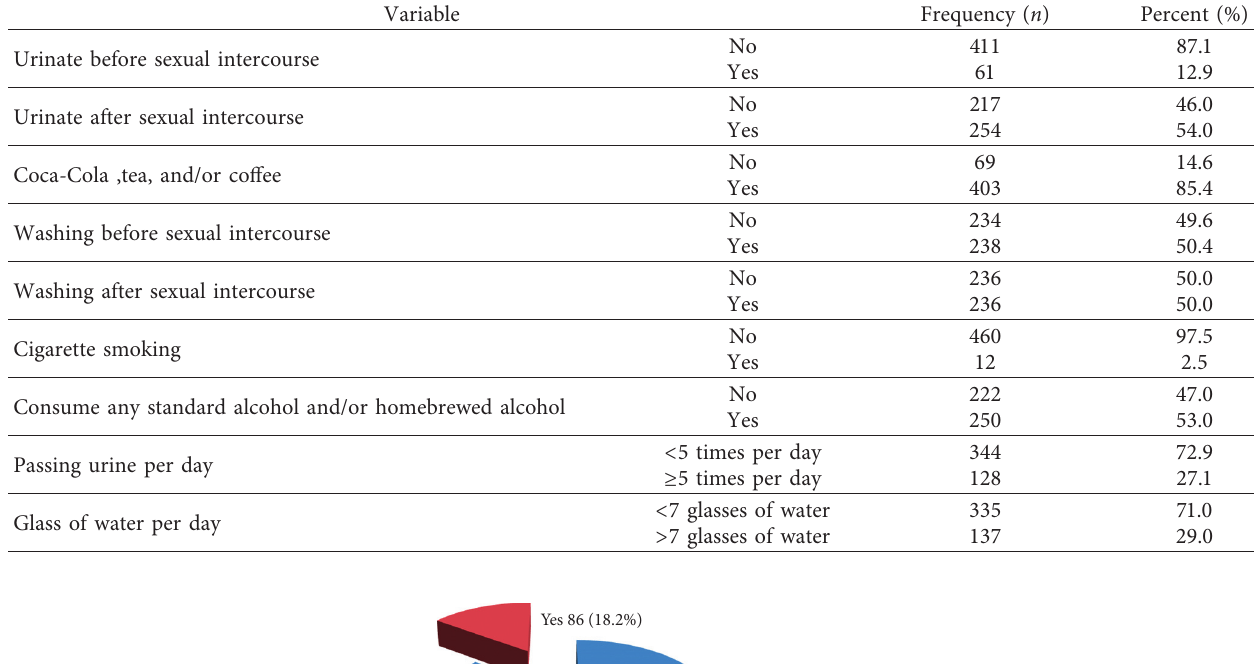
Table 3: Behavioral and dietary factors among adult patients attending the OPD in Tigray region hospitals, Ethiopia, 2019 ( N � 472). Variable